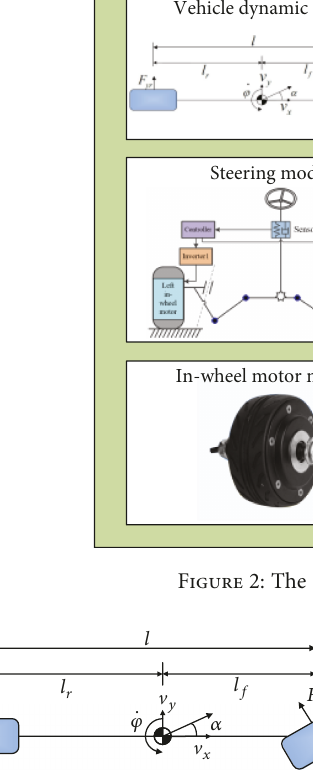
Figure 3: The linear model of 2-DOF unmanned driving